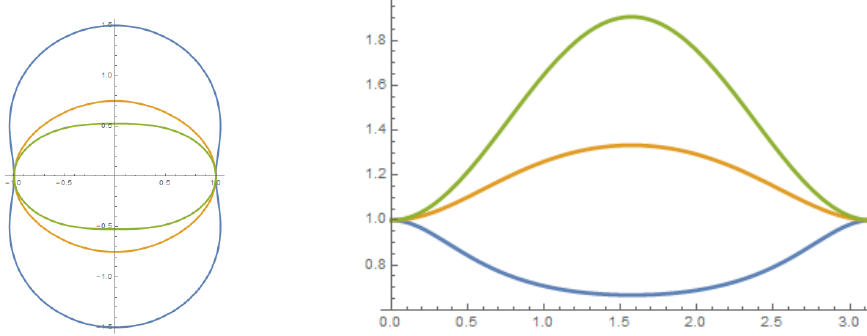
Figure 1: model class 1. contour curves of the density and H as a function of φ in the cases a = 1, b = 2, 0.5, 0.05, c = 1, β = 0